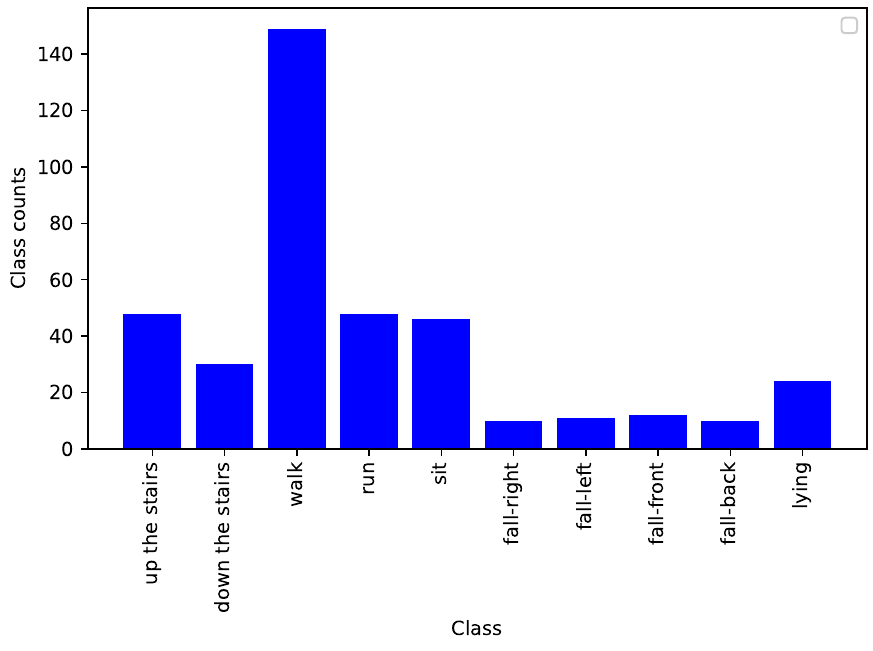
Figure 5. Bar chart of class distribution of all trials of a given participant (P01_290416), providing a strong visual indication of class imbalance in the